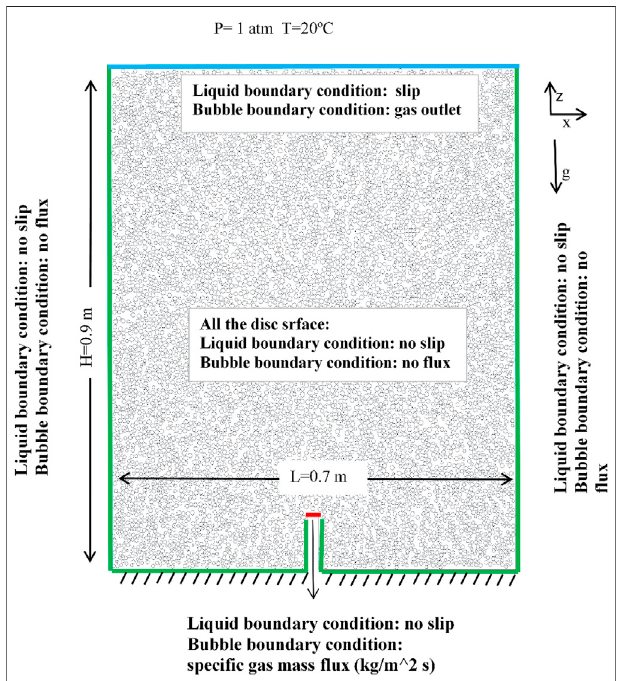
FIGURE 2 | Schematic sketch of geometry and boundary conditions for the current numerical study: no-water fl ow boundary conditions for the domain bottom boundary, the no-slip solid side boundaries and particle surface; speci fi ed gas fl ux is set as the bubble gas diffuser point (red line at the bottom).